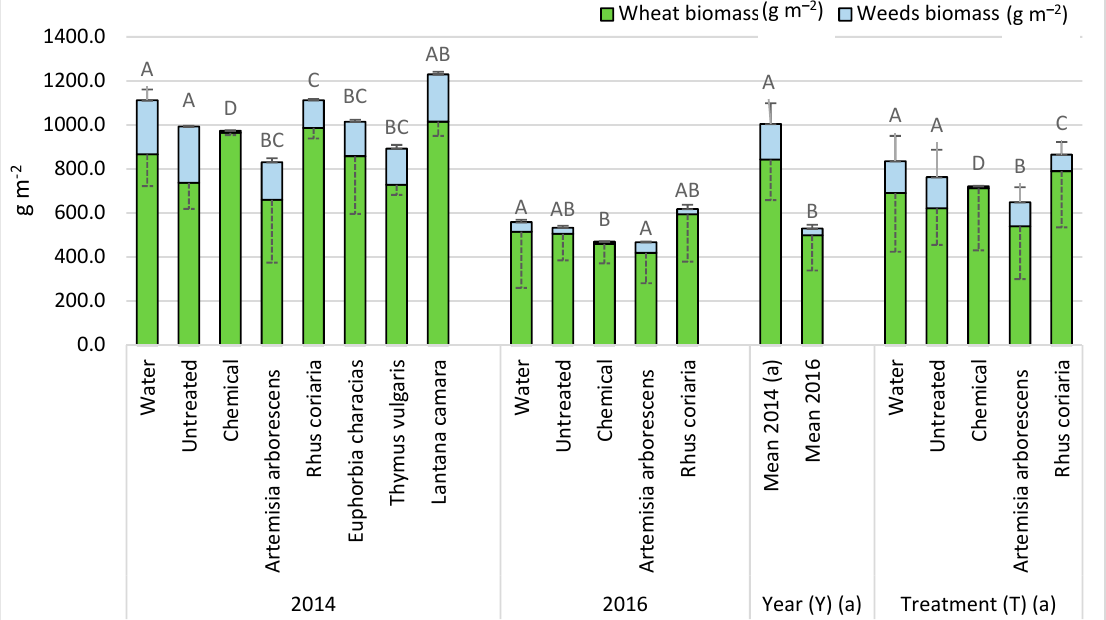
Figure 3. Total biomass (g m – 2 dm) of wheat and weeds measured at harvest time in treated and untreated plots. Mean values marked with “a” refer only to the treatments common to both years. Error bars indicate the standard deviation of each mean, respectively for wheat (downward dotted lines) and weeds (upward entire lines). In each group (2014, 2016, Year, and Treatment), values of weeds biomass accompanied by the same letter are not different at p ≤ 0.05 (HSD Tukey’s test).